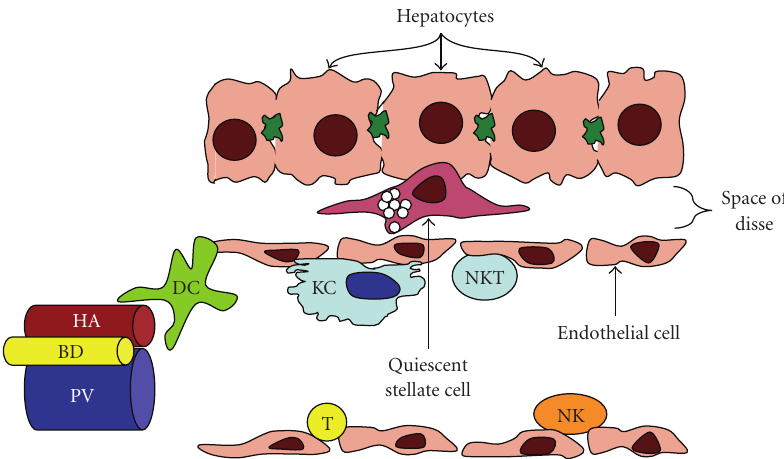
Figure 1: Diagramatic representation of the liver sinusoid. HA; hepatic artery. BD; bile duct. PV; portal vein. DC; dendritic cell. KC; Kup ff er cell. NKT; natural killer T cell. T; T cell. NK; natural killer